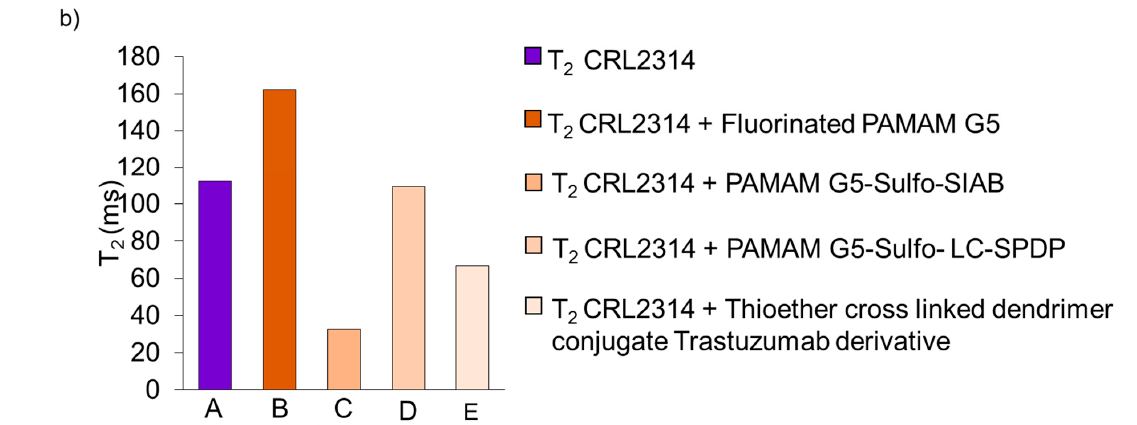
Figure 11. Results of T 1 ( a ) and T 2 ( b ) relaxation times for CRL-2314 cell culture in a 3D bioreactor (A), and the same culture with the addition of synthesized drugs 2 (B), 3 PAMAM G5-Sulfo-SIAB (C), 4 PAMAM G5-Sulfo- LC-SPDP (D) and 5 Thioether cross-linked dendrimer conjugate Trastuzumab derivative (E). The results of the relaxation times for the cultures of the CRL-2314 cells and cells of the same lineage with the addition of drugs 4 and 5 are shown below (Figure 12).